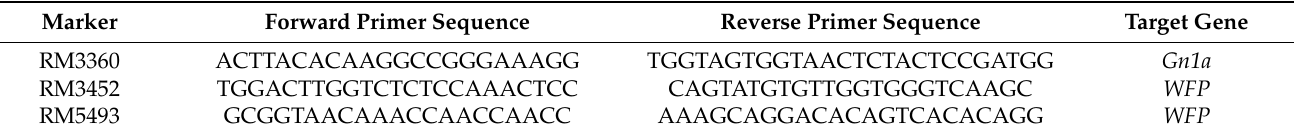
Table 2. List of microsatellite markers used to monitor the introgression of Gn1a and WFP in recipient lines. Marker Forward Primer Sequence Reverse Primer Sequence Target Gene RM3360 Gn1a